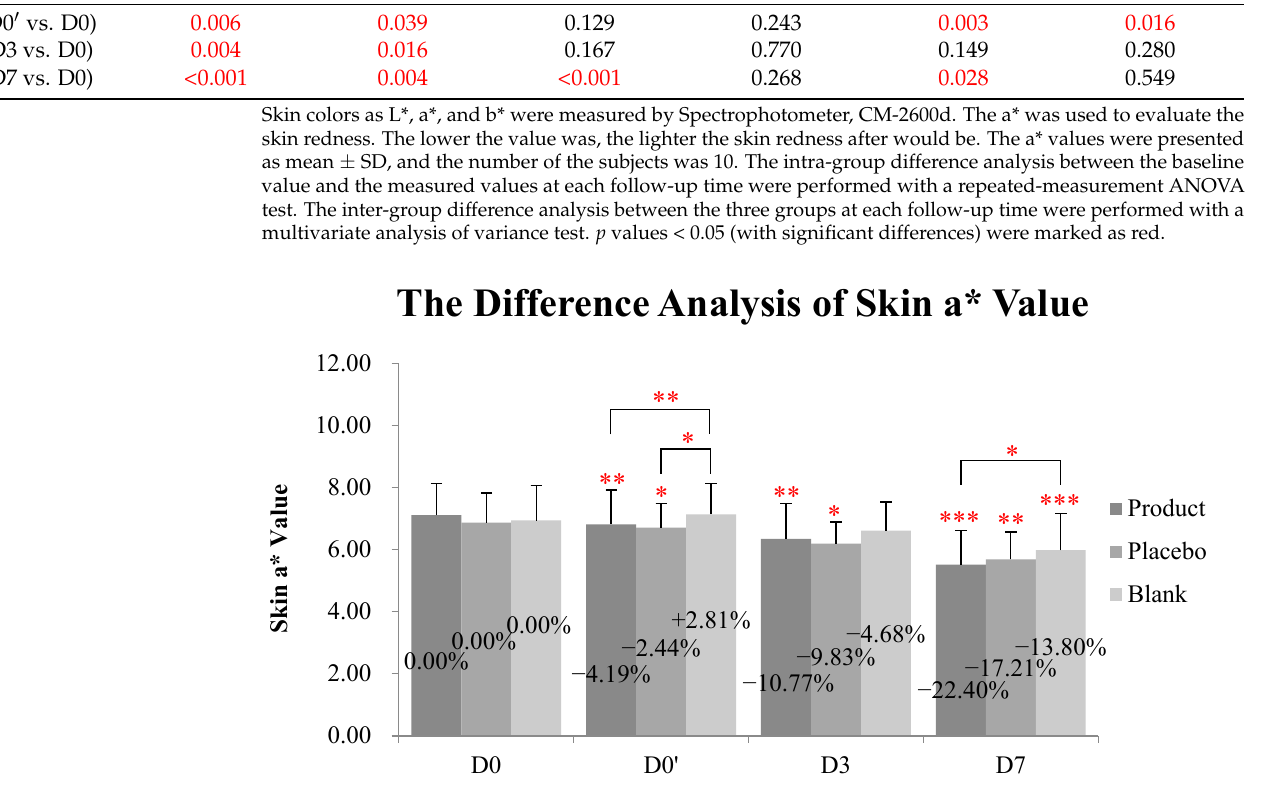
Table 2. Difference analysis of skin a * value.